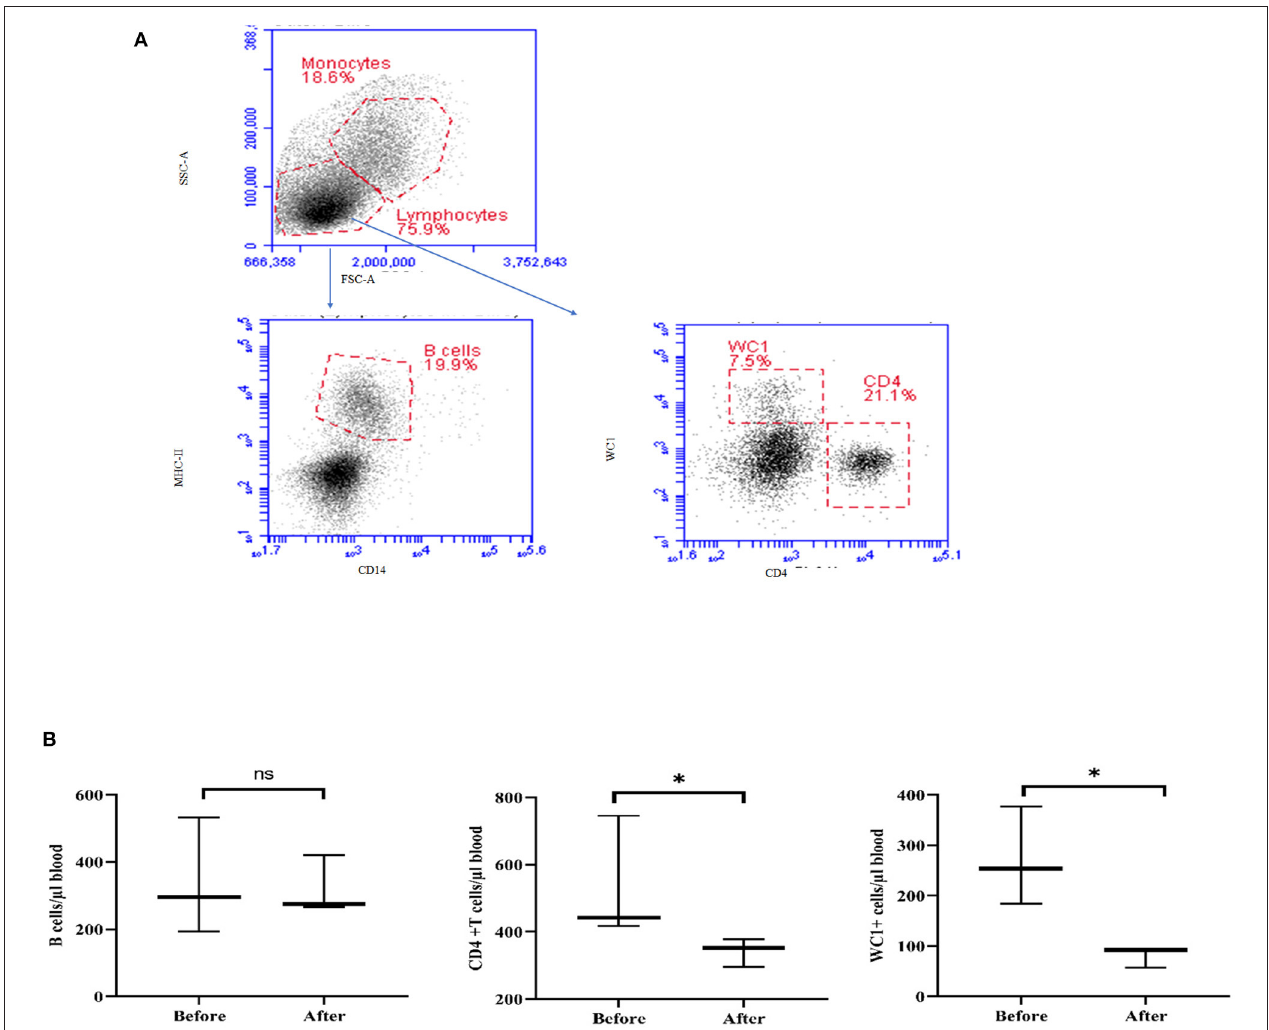
FIGURE 7 | Impact of acepromazine on lymphocyte composition in camel blood. (A) After gating on lymphocytes within the mononuclear cell population in the SSC-A/FSC-A dot plot, camel B cells were identified as MHC-II + CD14– cells in the CD14/MHC-II dot plot. CD4 + T cells and gd T cells were identified based on their single staining with CD4 and WC-1, respectively. (B) The numbers of camel B cells, CD4 + T cells, and gd T cells were estimated by multiplying their percentages in blood lymphocytes by the absolute number of lymphocytes. Median cell numbers are presented for all leukocyte subsets before and after treatment. Differences between the medians were calculated using the Mann–Whitney test and were considered significant (*) if p < 0.05, ns denotes non-significant at a p -value >